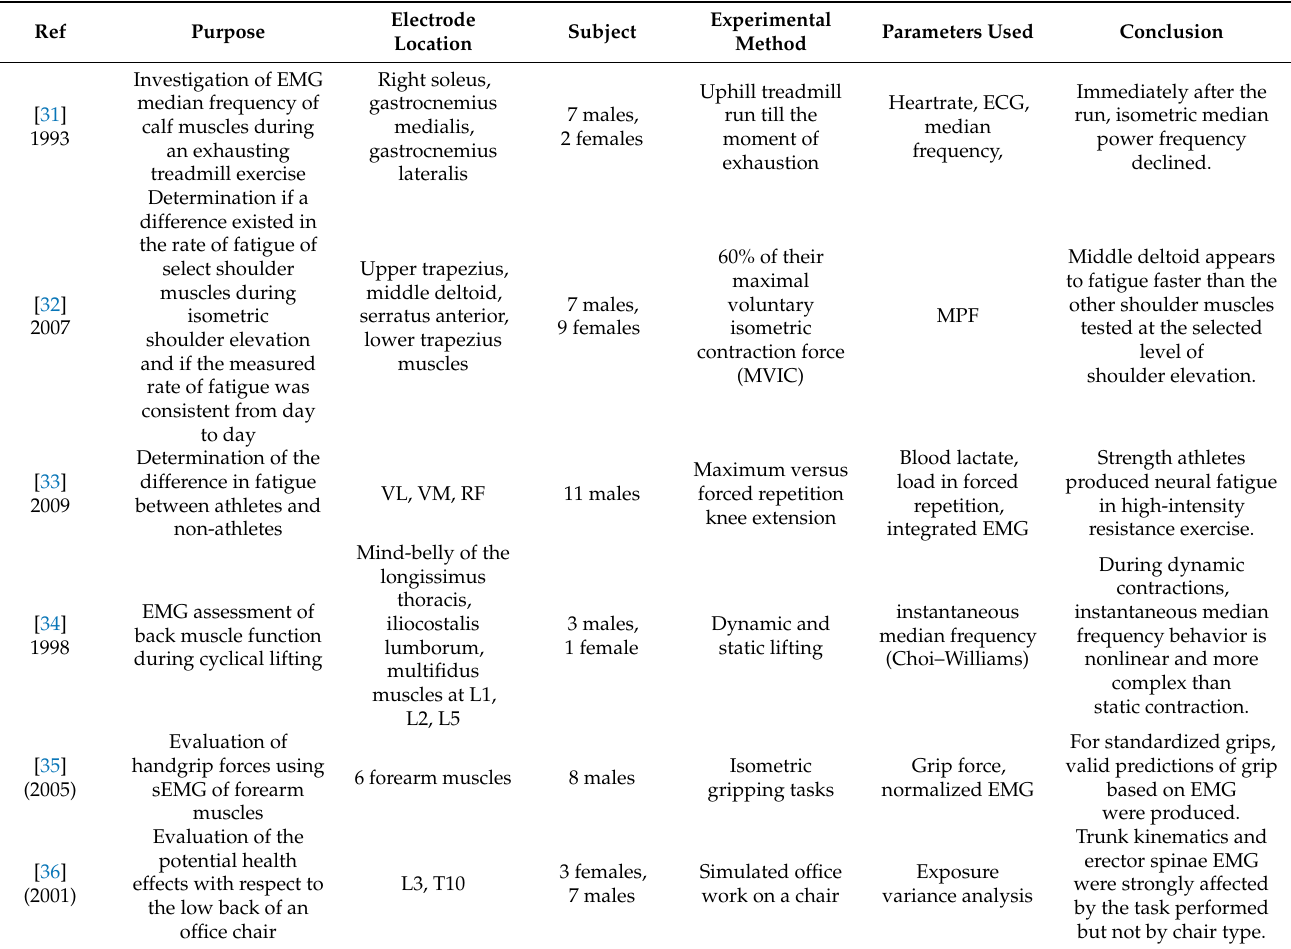
Table 2. Clinical studies conducted by measuring EMG during